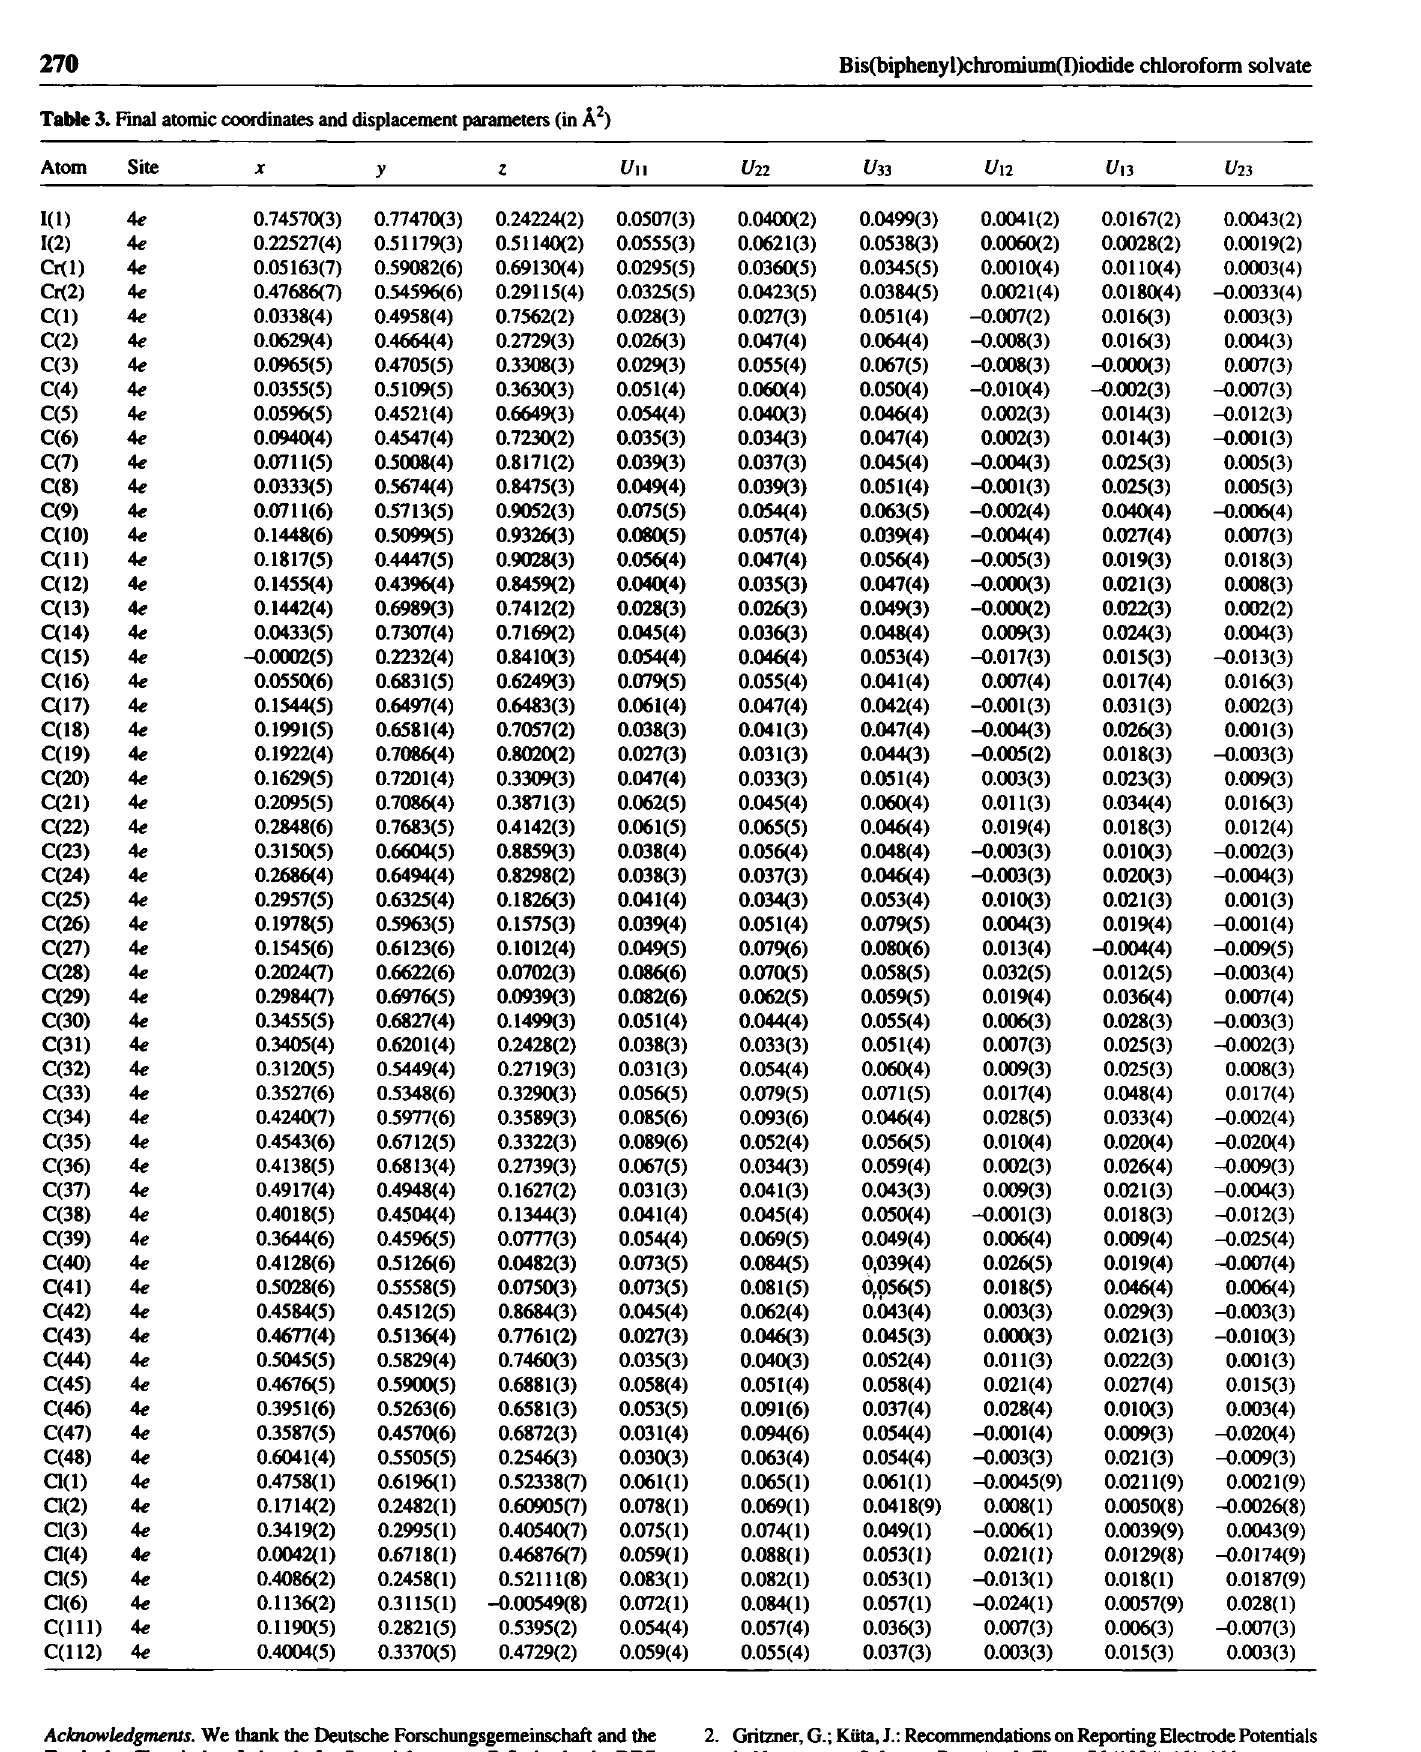
Table 3. Filial atomic coordinates and displacement parameters (in Â 2 ) Atom